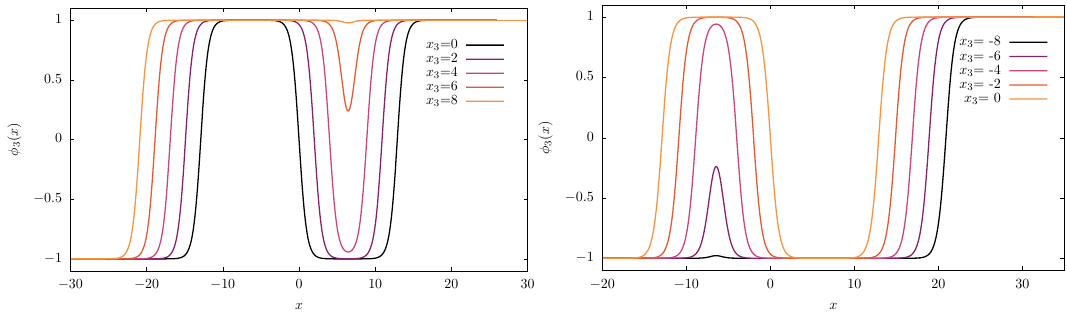
Figure 2 . Re(cid:13)ection-symmetric solutions (cid:30) 3 for various values of c .